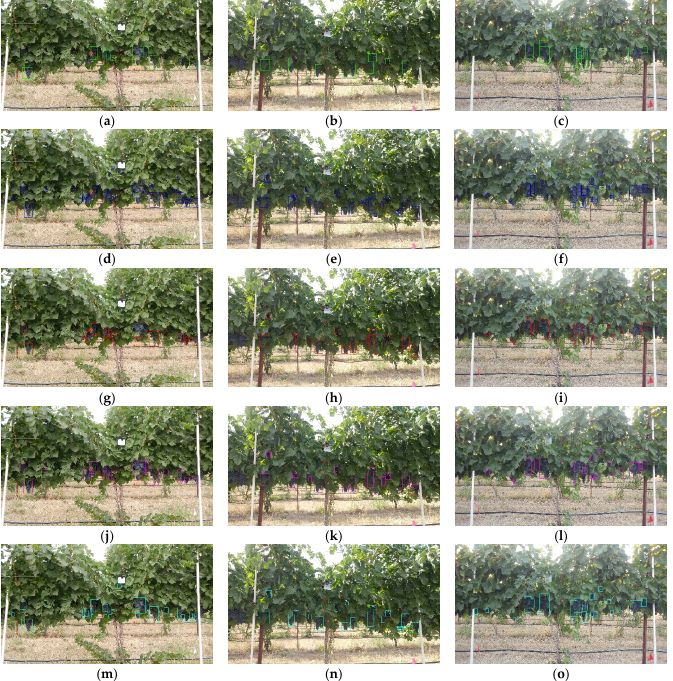
( o ) Figure A6. Demonstrations of detection results on the test set of Merlot (red variety) using ( a – c ) Figure A6. Demonstrations of detection results on the test set of Merlot (red variety) using ( a – c ) Faster R-CNN (bounding boxes in green color); ( d – f ) YOLOv3 (in blue color); ( g – i ) YOLOv4 (in red color); ( j – l ) YOLOv5 (in magenta color); and ( m – o ) Swin-transformer-YOLOv5 (in cyan color) under Faster R-CNN (bounding boxes in green color); ( d – f ) YOLOv3 (in blue color); ( g – i ) YOLOv4 (in red morning (left), noon (middle), and afternoon (right) sunlight directions/intensities. color); ( j – l ) YOLOv5 (in magenta color); and ( m – o ) Swin-transformer-YOLOv5 (in cyan color) under References 1. USDA/NASS QuickStats Query Tool. Available Online: https://quickstats.nass.usda.gov/ (accessed on 18 October 2022). morning (left), noon (middle), and afternoon (right) sunlight 2. Bellvert, J.; Mata, M.; Vallverdú, X.; Paris, C.; Marsal, J. Optimizing precision irrigation of a vineyard to improve water use efficiency and profitability by using a decision-oriented vine water consumption model. Precis. Agric. 2020 , 22 , 319–341. https://doi.org/10.1007/s11119-020-09718-2. 3. Zou, Z.; Shi, Z.; Guo, Y.; Ye, J. Object Detection in 20 Years: A Survey. arXiv 2019 , arXiv:1905.05055. 4. Jiao, L.C.; Zhang, F.; Liu, F.; Yang, S.Y.; Li, L.L.; Feng, Z.X.; Qu, R. A Survey of Deep Learning-Based Object Detection. IEEE Access 2019 , 7 , 128837–128868. https://doi.org/10.1109/access.2019.2939201.